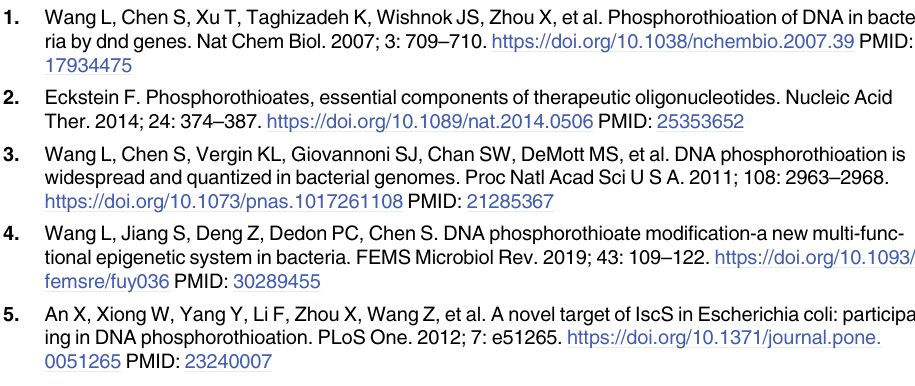
S3 Table. Kinetic signals from SMRT sequencing at modified bases. (GFF) S4 Table. Bacteria strains containing PT modification and their corresponding PT-modi- fied consensus motifs. This is a.CSV file that can be open in any free text editors or Microsoft